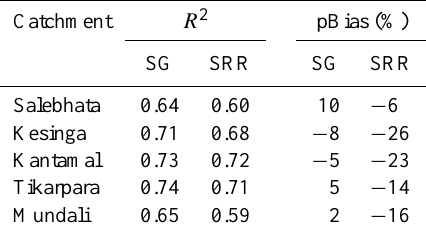
Table 9. Nash–Sutcliffe index of simulated stream flow for different precipitation estimates (labels according to Table 2). Numbers in parenthesis were obtained with the SG and SRC input, respectively, but using model parameters optimised for